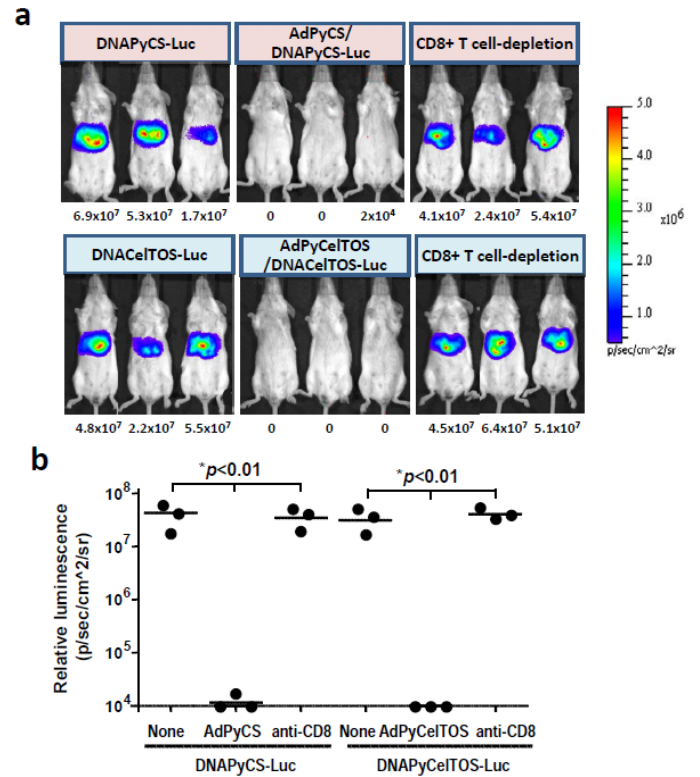
Figure 5. CD8 + T cell-mediated inhibition of luciferase expression in mice upon HTV injection of plasmid DNA, co-encoding genes for a malaria antigen and luciferase, by immunization with rAd expressing the antigen. ( a ) CD8 + T cell population was depleted from malaria vaccine-immunized mice before HTV injection with plasmid DNA co-encoding a malaria antigen and luciferase, and luciferase expression was assessed by noninvasive bioluminescence imaging; ( b ) The bioluminescent signal intensity was quantified in various groups of mice upon HTV injection of plasmid DNA co-encoding a malaria antigen and luciferase. The groups include naïve mice, malaria vaccine-immunized mice, and malaria vaccine-immunized mice that were depleted of CD8 + T cells in